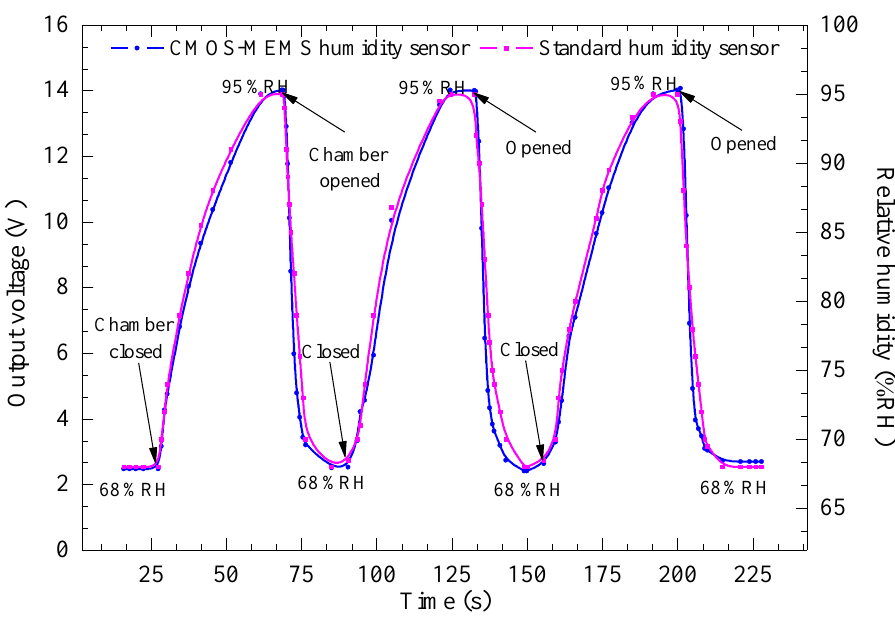
Figure 12. Response, recovery, and repeatability of the device and standard humidity sensor vs. time for three cycles at operating frequency of 2 Hz at 5 V pp